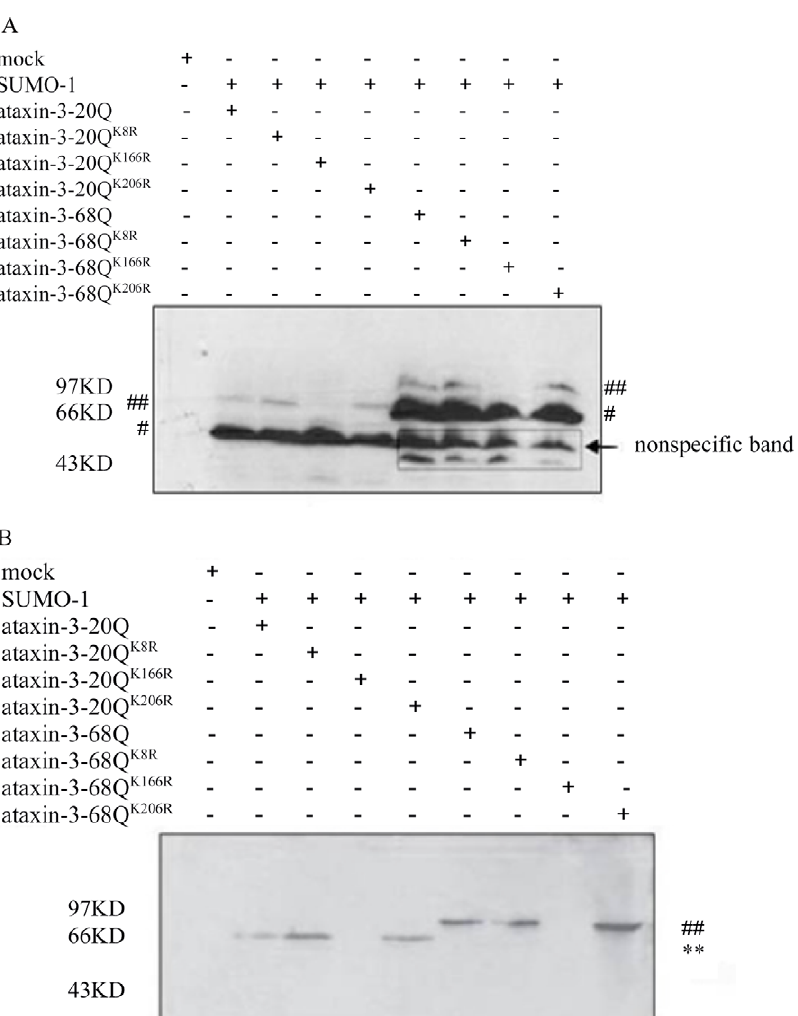
Figure 1. Identification of the SUMO-1 modification sites in ataxin-3. (A) HEK293 cells were used to co-express ataxin-3, ataxin-3 K8R , ataxin- 3 K166R , or ataxin-3 K206R with SUMO-1. 10% lysates were precipitated by TCA and subjected to immunoblotting. # ataxin-3 main bands, ## ataxin-3 relative levels of modified and unmodified (whole-cell–TCA precipitates). (B) The tagged proteins were enriched with NTA magnetic nickel columns and detected by immunoblotting with SUMO-1 antibody. **, ataxin-3-20Q modified by SUMO-1, ## , ataxin-3-68Q modified by